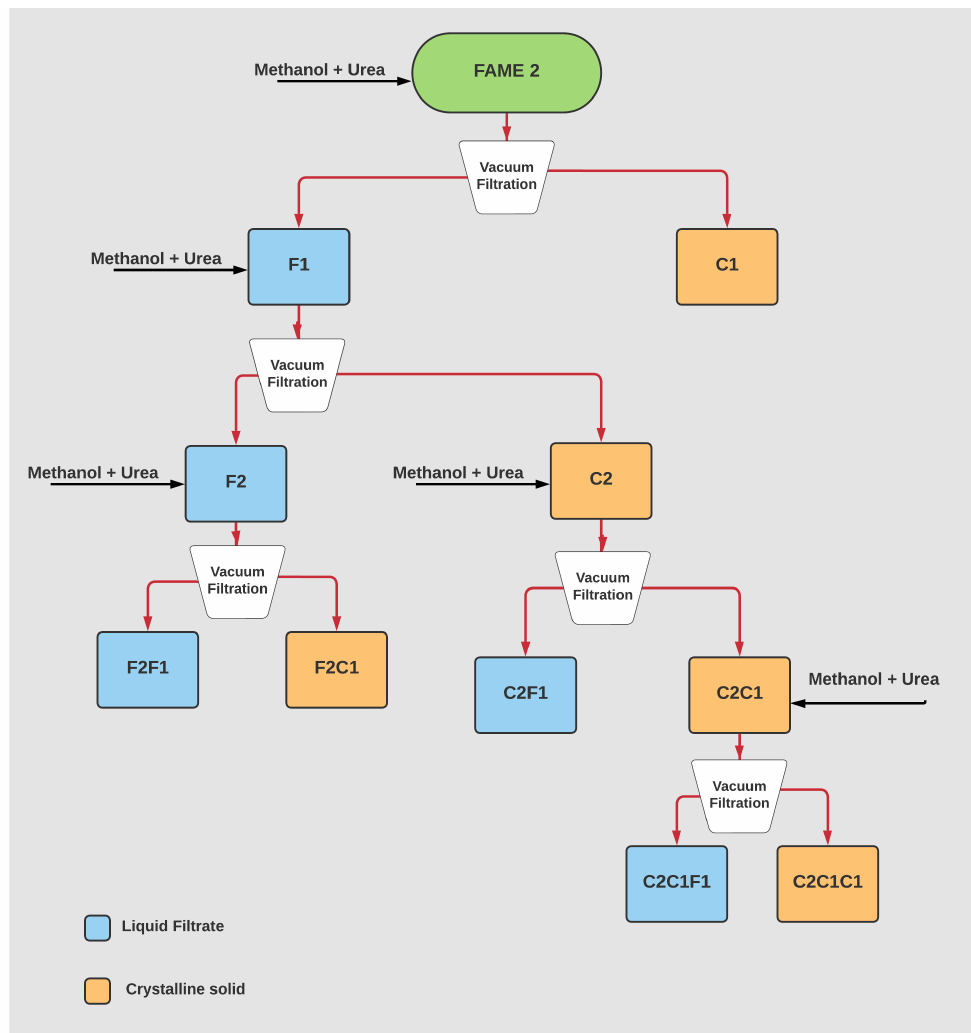
Figure 4. Urea crystallization sequence